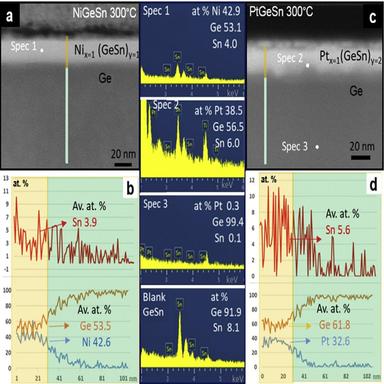
STEM imaging and corresponding EDX line scans for the regions marked with brown and blue measured for the Ni(GeSn) sample (a and b), and Pt(GeSn) sample (c and d), both annealed at 300 °C. Middle column shows EDX point spectra from the marked regions together with the blank GeSn spectrum. Corresponding quant data averaged across the region marked in brown and from the point spectra are also shown. (For interpretation of the references to colour in this figure legend, the reader is referred to the web versio